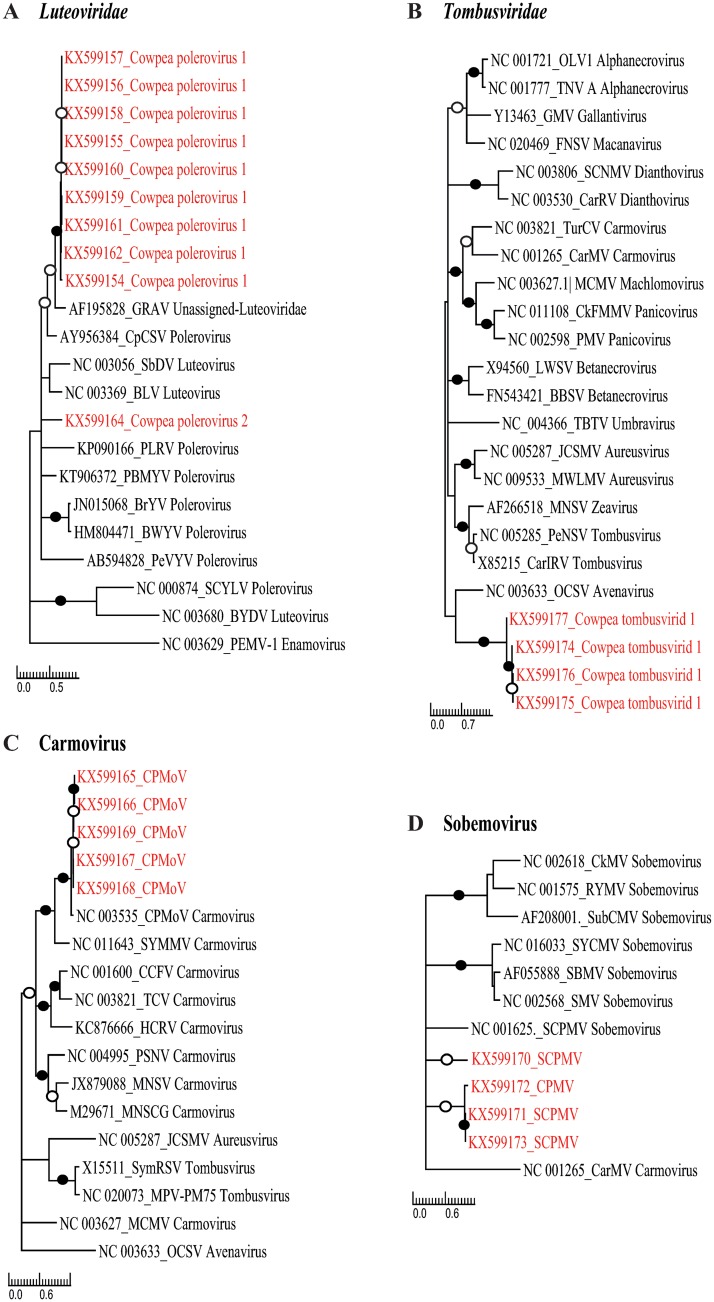
Maximum-likelihood phylogenetic trees depicting the relatedness of cowpea viruses from Burkina Faso.A) Maximum-likelihood phylogenetic trees of partial cp genes from nine isolates of Cowpea polerovirus 1 and representative species from the family Luteoviridae. SCYLV, Sugarcane yellow leaf virus; PLRV, Potato leafroll virus; PeVYV, Pepper vein yellows virus; CpCSV, Chickpea chlorotic stunt virus; BrYV, Brassica yellows virus; BWYV, Beet western yellows virus; BYDV, Barley yellow dwarf virus; BLRV, Bean leafroll virus; SbDV, Soybean dwarf virus; PEMV-1, Pea enation mosaic virus-1; GRAV, Groundnut rosette assistor virus; PBMYV, Phasey bean mild yellows virus. B) Maximum-likelihood phylogenetic trees of partial RdRp genes from four isolates of Cowpea tombusvirid-1 and representative species from the family Tombusviridae. TurCV, Turnip crinkle virus; MNSV, Melon necrotic spot virus; MCMV, Maize chlorotic mottle virus; JCSMV, Johnsongrass chlorotic stripe mosaic virus; OCSV, Oat chlorotic stunt virus; TNV A, Tobacco necrosis virus A; OLV1, Olive latent virus 1; PMV, Panicum mosaic virus; CMMV, Cocksfoot mild mosaic virus; CarMV, Carnation mottle virus; MWLMV, Maize white line mosaic virus; PNSV, Pelargonium necrotic spot virus; CIRV, Carnation Italian ringspot virus; GaMV, Galinsoga mosaic virus; FNSV, Furcraea necrotic streak virus; LWSV, Leek white stripe virus; BBSV, Beet black scorch virus; SCNMV, Sweet clover necrotic mosaic virus; CRSV, Carnation ringspot virus; CkMV, Cocksfoot mottle virus. C) Maximum-likelihood phylogenetic trees of partial RdRp gene from 5 isolates of CPMoV from Burkina Faso and representative species from Carmovirus genus and from the family Tombusviridae. CCFV, Cardamine chlorotic fleck virus; SYMMV, Soybean yellow mottle mosaic virus; HCRV, Hibiscus chlorotic ringspot virus; PSNV, Pea stem necrosis virus; MNSCG, Melon necrotic spot virus; CymRSV, Cymbidium ringspot tombusvirus; MPV-PM75, Moroccan pepper virus. D: Maximum-likelihood phylogenetic trees of partial RdRp genes from five isolates of SCPMV from Burkina Faso and representative species of the Sobemovirus genus. SCPMV, Southern cowpea mosaic virus; RYMV, Rice yellow Mottle virus; CfMV, Cocksfoot mottle virus_sobemovirus; SCMoV, Subterranean clover mottle virus; SYCMV, Soybean yellow common mosaic virus; SBMV, Southern bean mosaic virus; SeMV, Sesbania mosaic virus; CarMV, Carnation mottle virus. For all four trees, branches associated with a filled dot have bootstrap support above 90 per cent whereas those with an unfilled dot have bootstrap support above 70 per cent. All branches with less than 50 percent bootstrap support were collapsed.